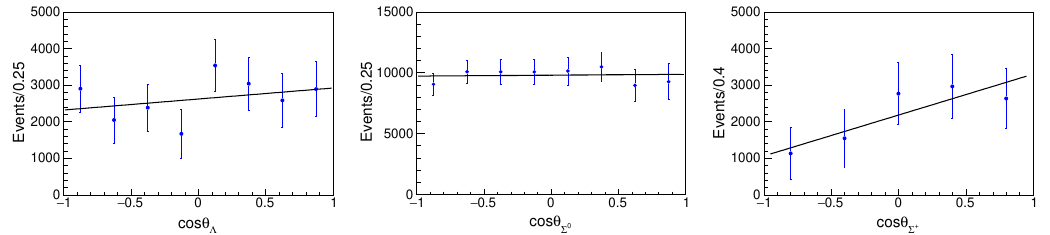
Table 5 . The values of Signal yield Σ + K ∗− .